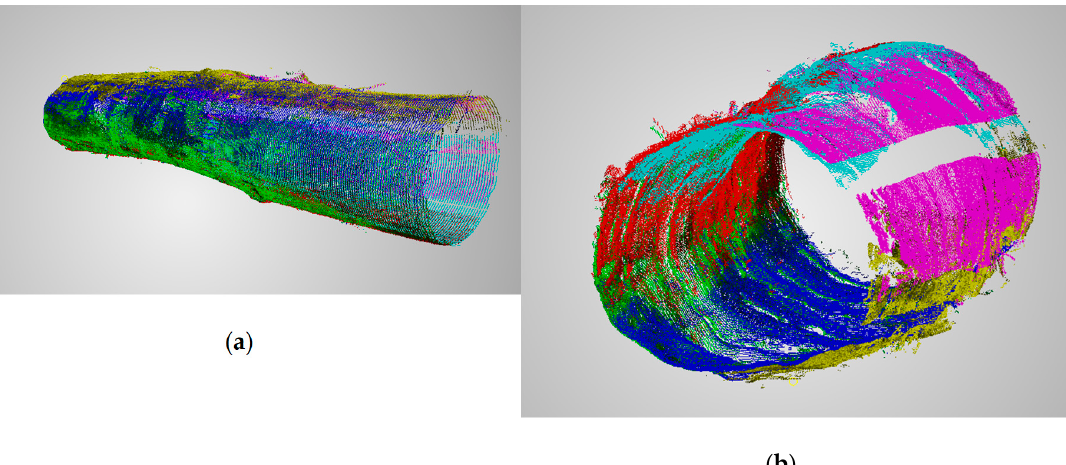
Figure 12. Exemplary effects of composing point clouds from different measuring heads. Data from different systems are marked with colors: ( a ) side view; ( b ) front view. Parts of magenta and yellow clouds are missing because they were occluded by the conveyor during measurement.